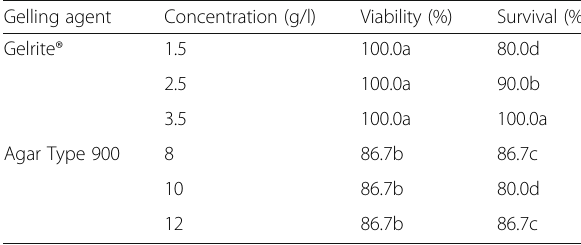
Table 1 Effects of different type of gelling agents on the viability and survival of oil palm polyembryoids